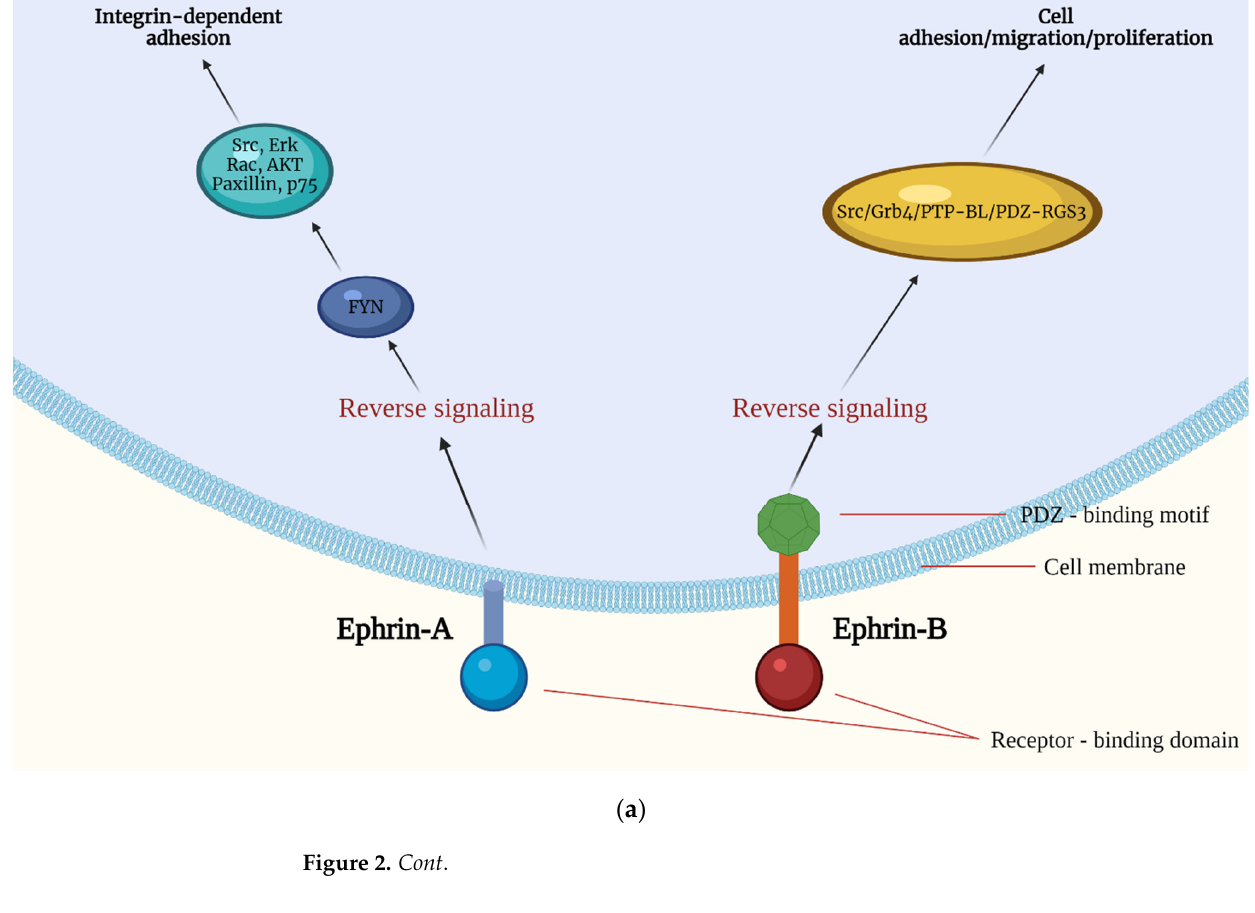
Figure 1. EPH/ephrin expression gradient in gastrointestinal tract. Black arrows: the points of max- imal expression. Created with BioRender.com, accessed on 20 February 2022.